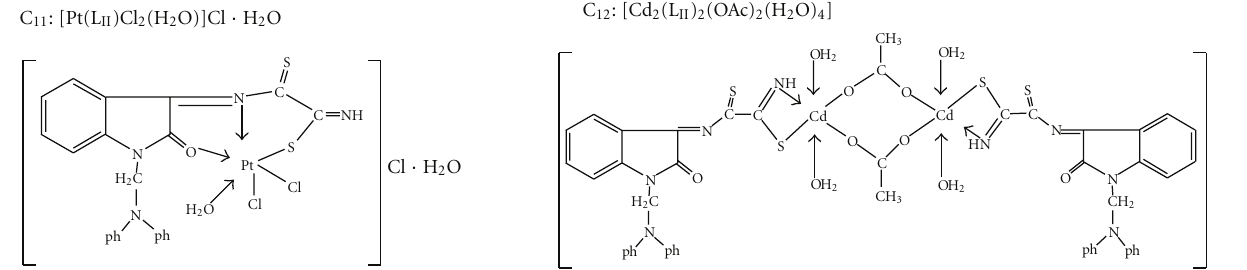
Scheme 3: Suggested structures of Schi ff and Mannich base complexes.